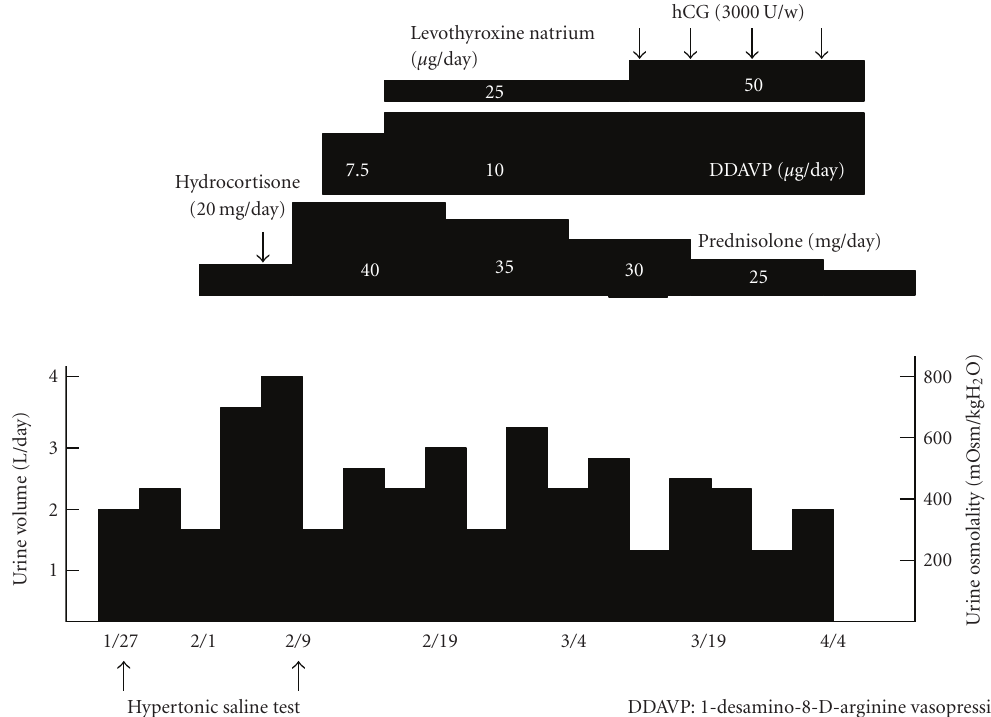
Figure 5: Clinical